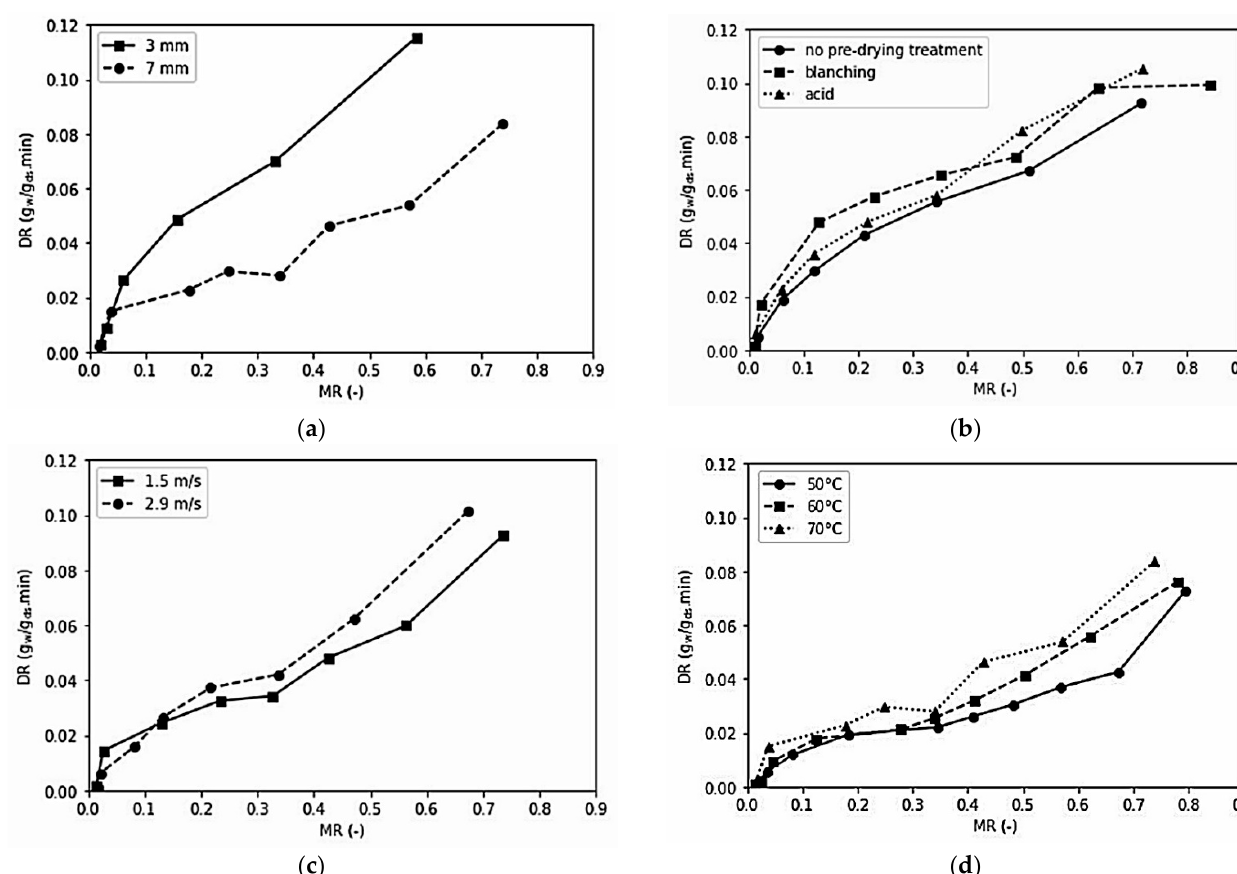
Figure 2. Drying rate as a function of moisture ratio at ( a ) 70 °C drying temperature, 2.2 m/s air velocity, no pre-drying treatment; ( b ) 50 °C drying temperature, 1.5 m/s air velocity, 3 mm sample thickness; ( c ) 60 °C drying temperature, 5 mm sample thickness, no pre-drying treatment; ( d ) 2.2 m/s air velocity, 7 mm sample thickness, no pre-drying treatment.